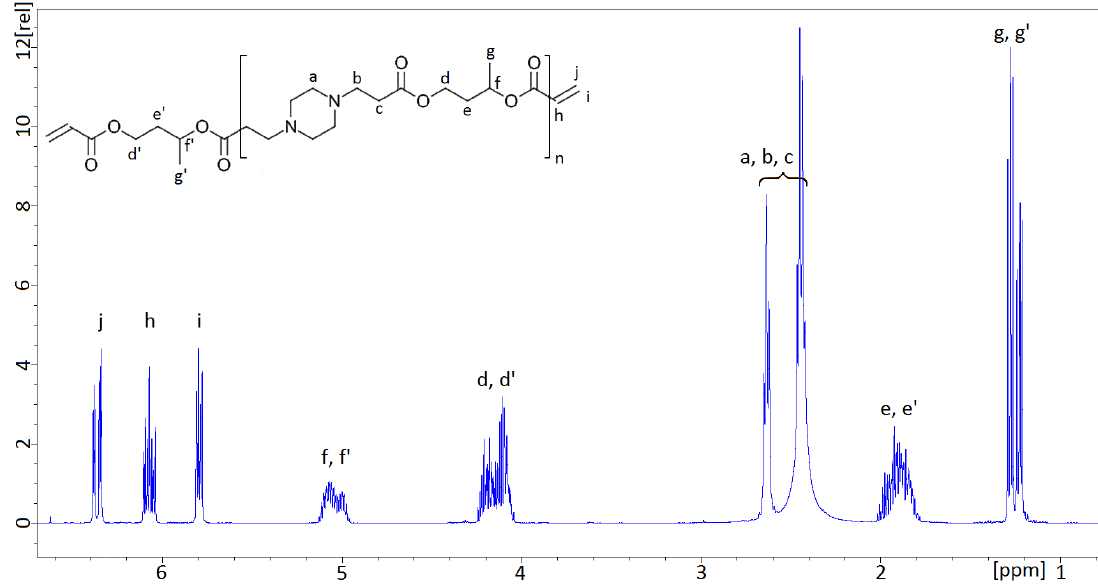
Figure 2. Nuclear magnetic resonance (NMR) spectra of 1,3-AOBAE. a–c are protons in the PIP ring and of the ethylene groups connecting the amino group with the ester bond; d are the methylene protons adjacent to the ester bond; e are the methylene protons in the central atom of the propylene chain; f is the methine proton; i, j and h are the acrylic